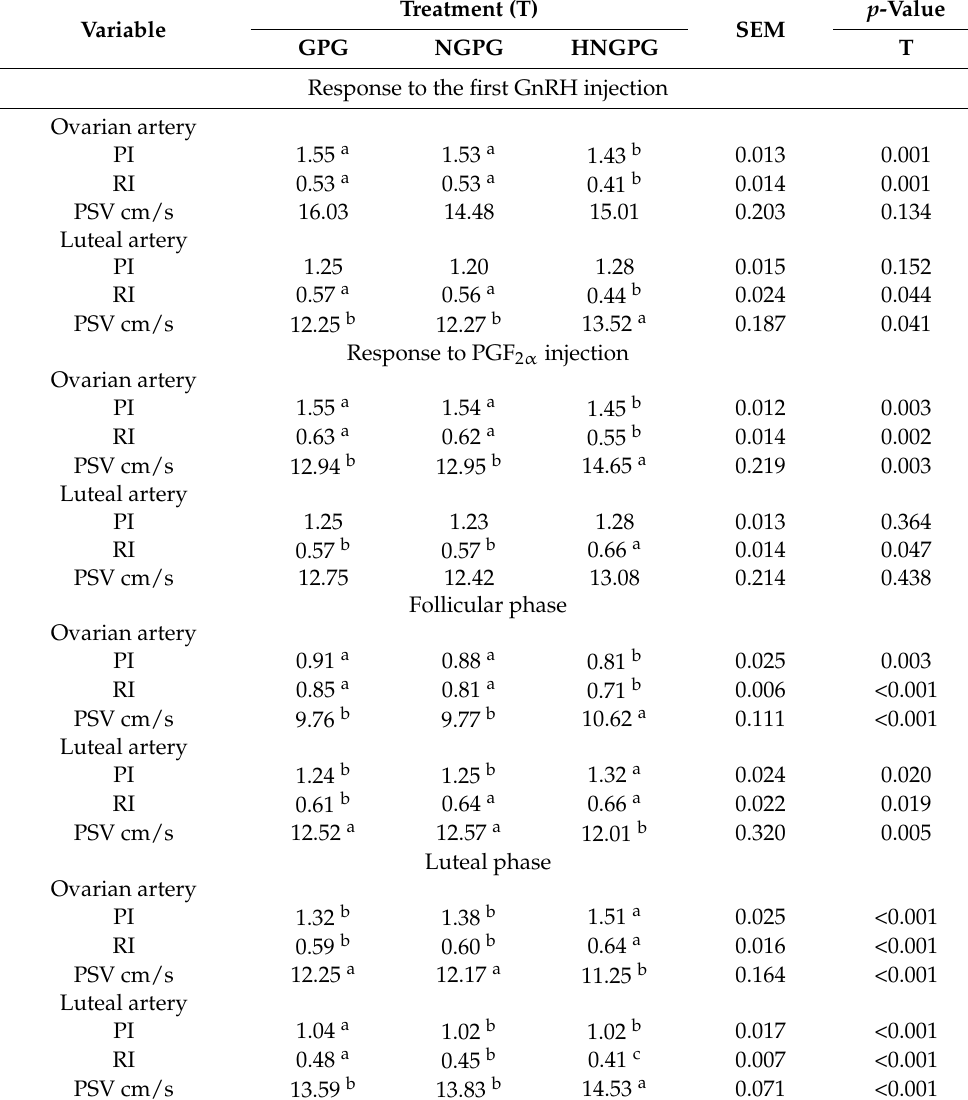
Table 3. Ovarian artery and luteal artery hemodynamic patterns in response to Ovsynch protocol using conventional hormones (GPG: 50 mg gonadorelin and 125 mg cloprostenol) or nanodelivered hormones with different doses (NGPG: 50 mg gonadorelin and 125 mg cloprostenol and